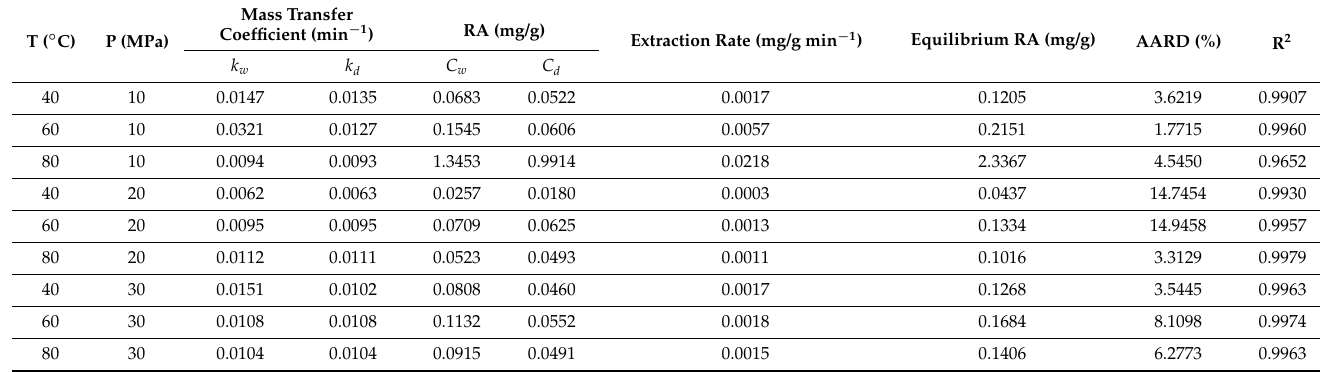
Table 4. Mass transfer coefficient and extraction rate of RA in ethanol-assisted SCCO 2 system using Patricelli model.